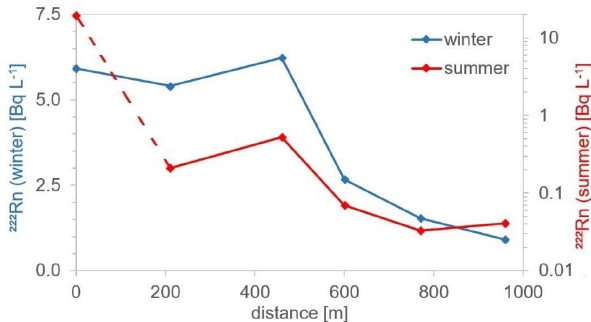
Figure 5. 222 Rn concentration patterns along the stream sections during winter (January 2019) and summer (September 2020) cam- paigns; the dashed line indicates that the most upstream summer sample cannot be considered representative of stream water (see text